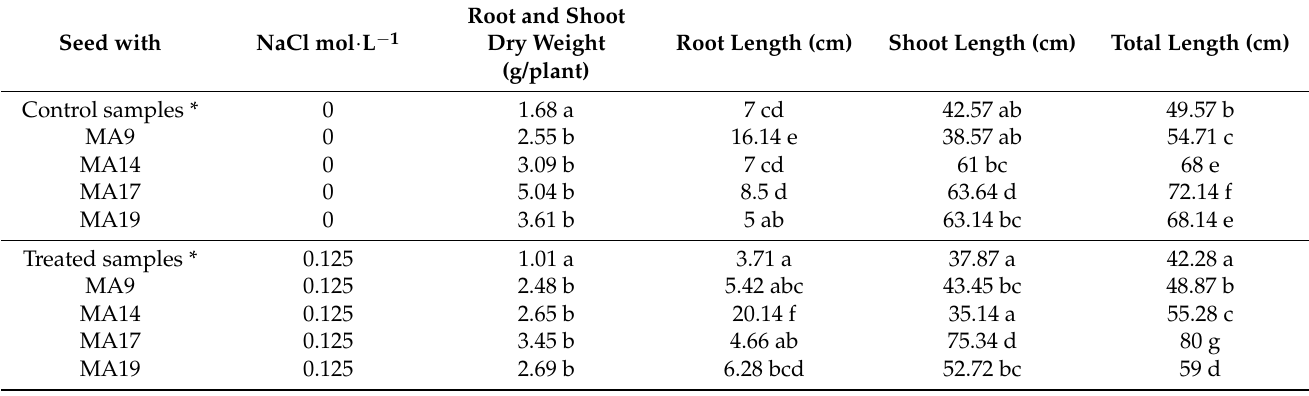
Table 4. Influence of seed biopriming with PGPB on growth parameters of wheat plants under control and saline (in vivo)